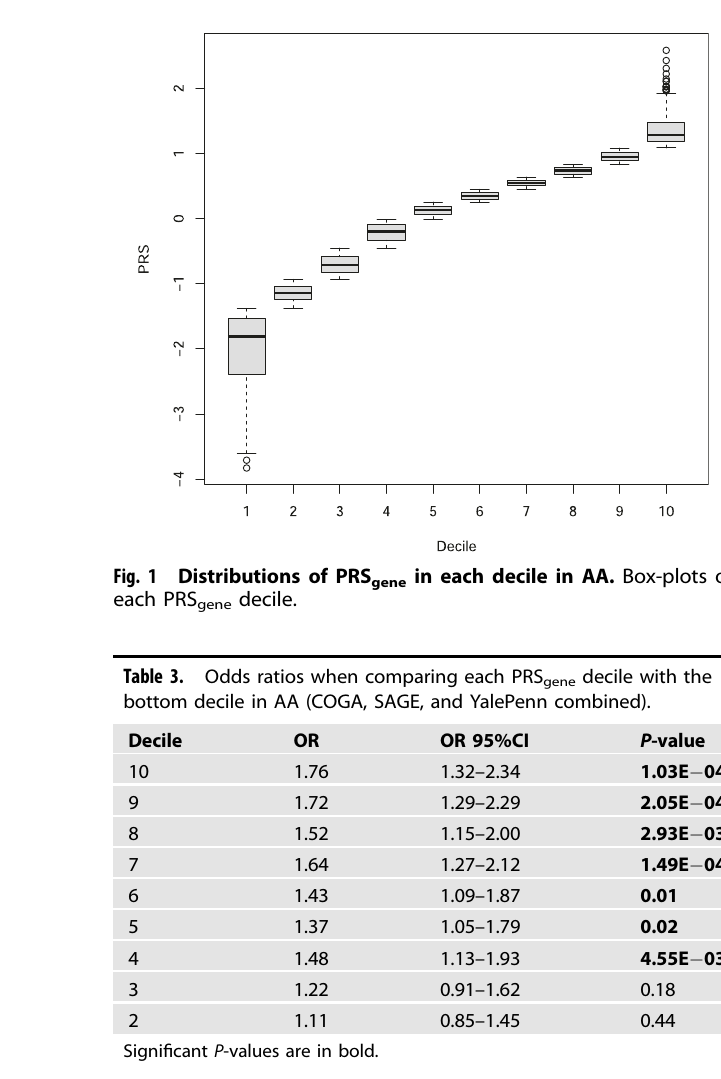
drugs approved by the FDA or in clinical trials. Among them, four ( DRD2 , PDE4B , GRM5 , and SLC6A9 ) were drug target genes for AUD treatment (Table S6); for those 22 genes that were targets of drugs to treat diseases other than AUD, 21 were involved in the signi fi cant GOBPs identi fi ed and fi ve ( EIF4E , ESR1 , MAPT , METAP1 , and TNKS ) were reported by previous GWAS of AUD-related phenotypes (Table S2). DISCUSSION In this study, we found that gene-based PRS (PRS gene ) calculated using 858 variants from 410 genes were signi fi cantly associated with AUD in both AA and EA, and outperformed the PRS calculated using all variants (PRS all ) in AA. Compared to the bottom decile, those at the top PRS gene decile were nearly twice as likely to be AUD cases (OR = 1.76) in AA. The 410 genes included in calculating PRS gene were enriched in 54 GOBPs, and many of them are likely to be AUD-related. They were also enriched in brain tissues. In addition, four genes were targets of drugs in Phase II or III clinical trials to treat AUD; 22 genes were targets of drugs approved by the FDA or in clinical trials to treat other diseases but may be repurposed to treat AUD. Together, these fi ndings showed that biologically meaningful polygenic scores can be characterized in non-European ancestry individuals by